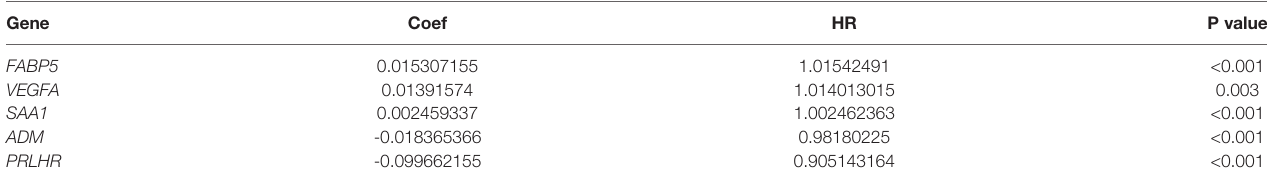
TABLE 4 | Multivariate Cox analysis of 5 differentially expressed immune-related genes. Gene Coef HR P value